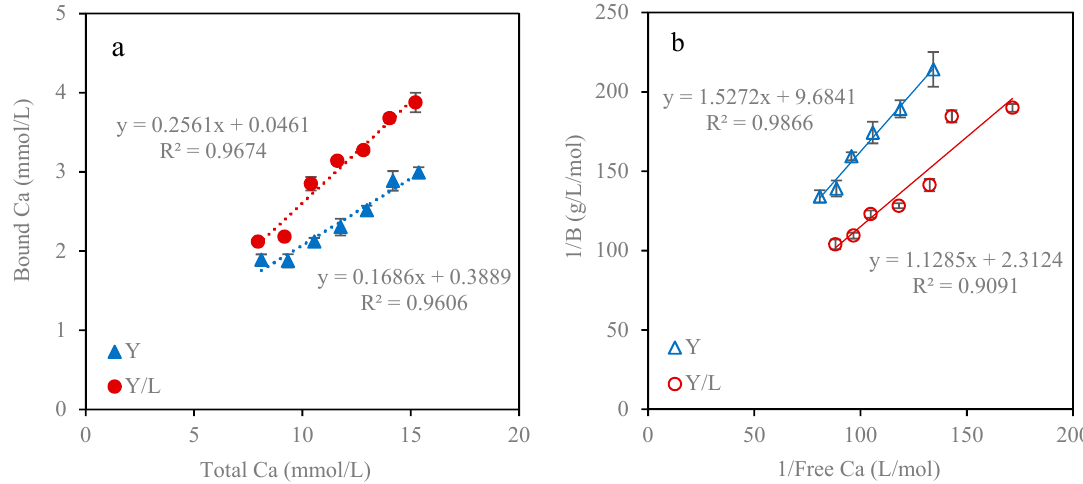
Figure 5. Calcium binding measurements in Y and Y/L snack at pH 7.0 and 37 °C ( a ) The relationship between bound Ca and total Ca; ( b ) Klotz plot analysis for the binding constant calculation. B represents the bound Ca to the per gram of protein.